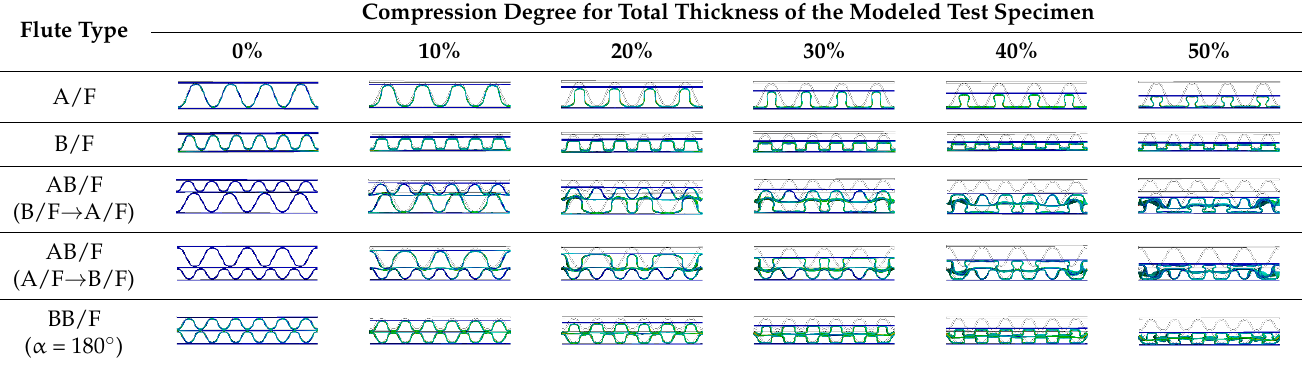
Figure 4. FEA result of the modeled test specimen by flute type (20% compression for each thickness of the modeled test specimen). Table 4. Flat crush process of the modeled test specimen by flute type through FEA.